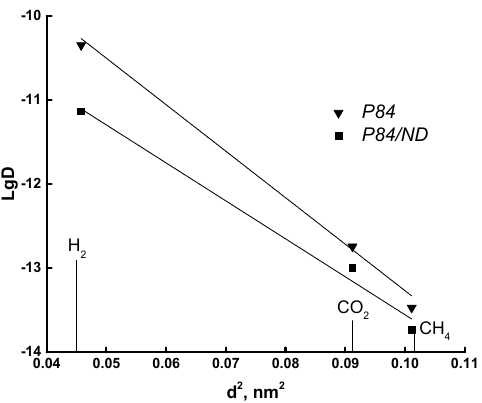
Figure 4. Dependence of diffusion coefficient on effective diameter of gas molecules for P84 and P84/ND membranes.